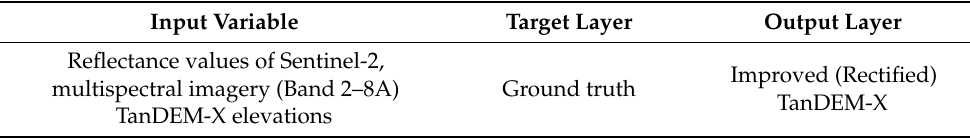
Figure 1. Schematic diagram of a two-layer feedforward network . Table 4. Input variable, target, and output layers in ANN training. Table 4 . Input variable, target, and output layers in ANN training.